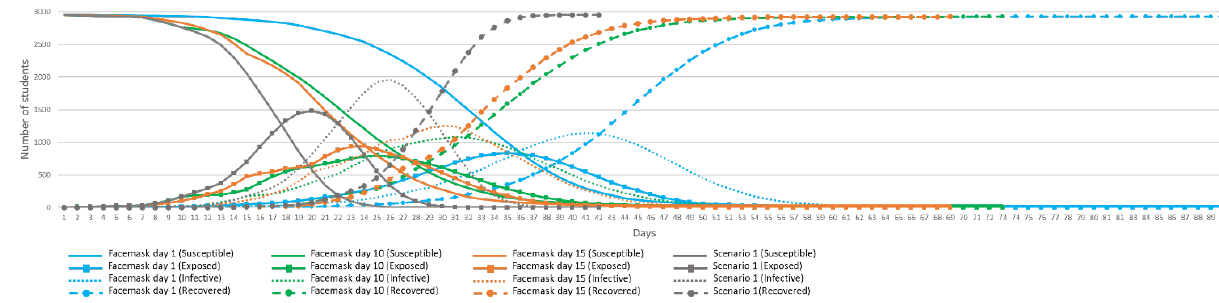
ISPRS Int. J. Geo-Inf. 2021 , 10 , x FOR PEER REVIEW Figure A1. Comparison of the evolution of the disease between Scenarios 2 (Facemask Use) against Scenario 1 (No Measures).